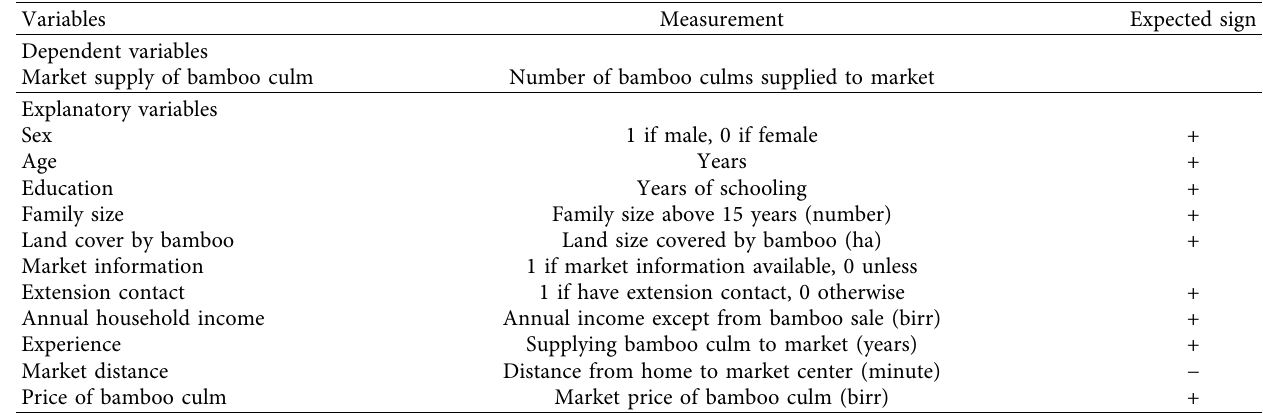
Table 1: Variables in the multiple linear regression (MLR)